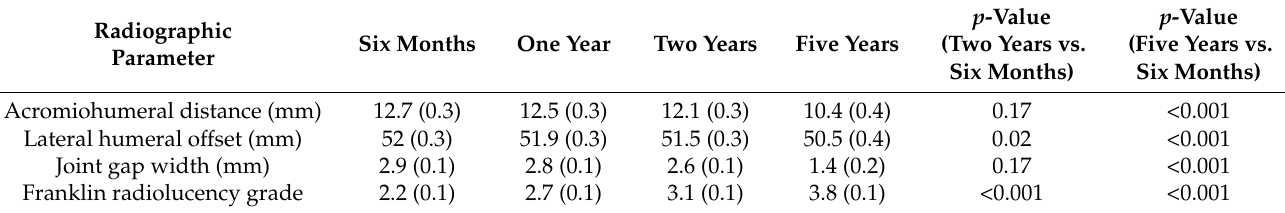
Table 2. Change in radiographic parameters with time.